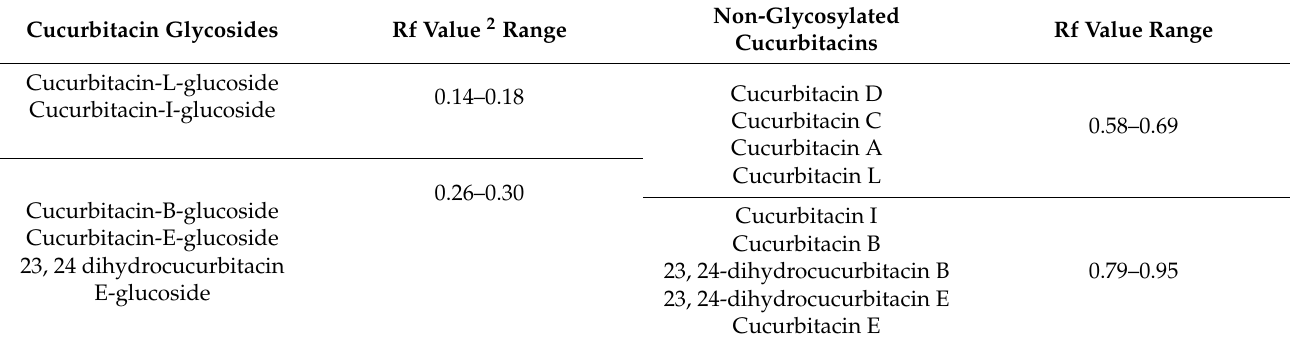
Cucurbitacin Glycosides